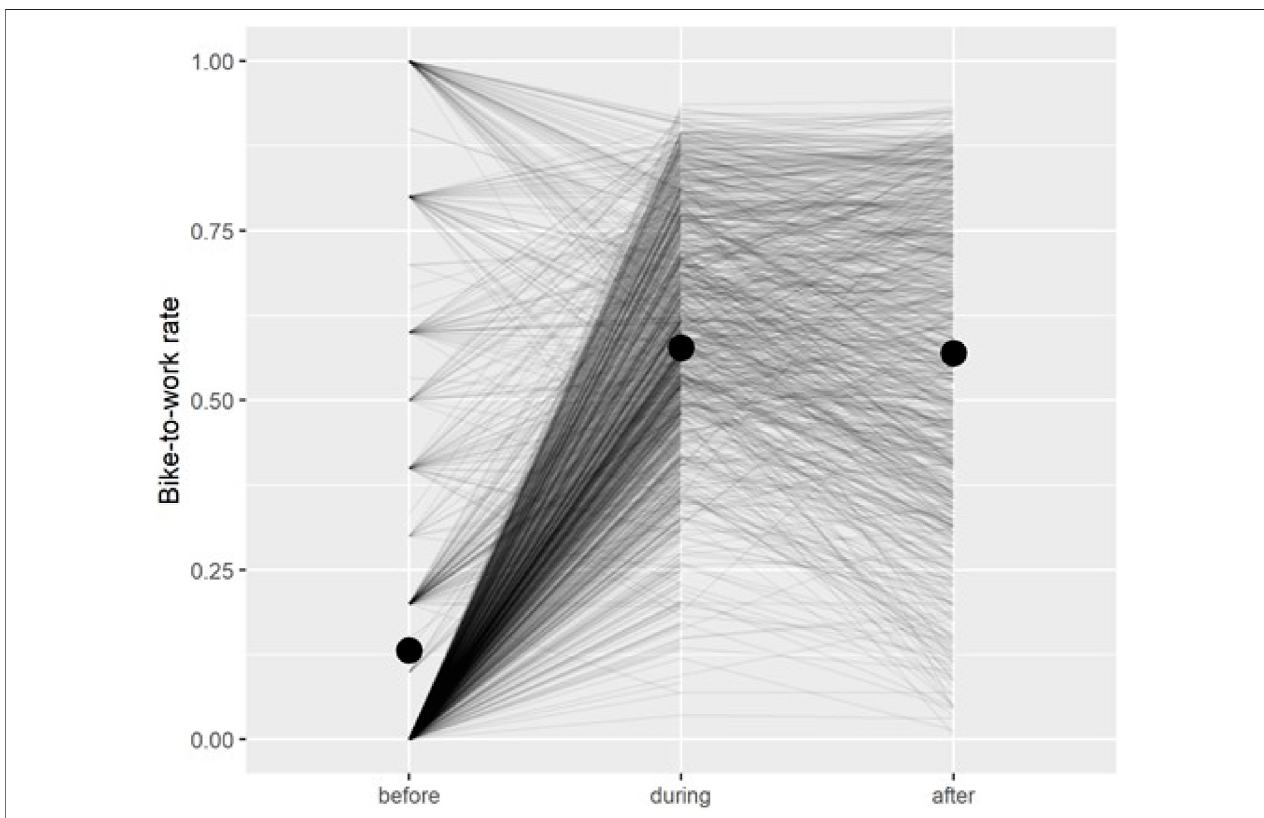
FIGURE 12 | Model predicted bike-to-work rate of bike-lending participants by intervention phase from survey (before) and trip logs (during, after).